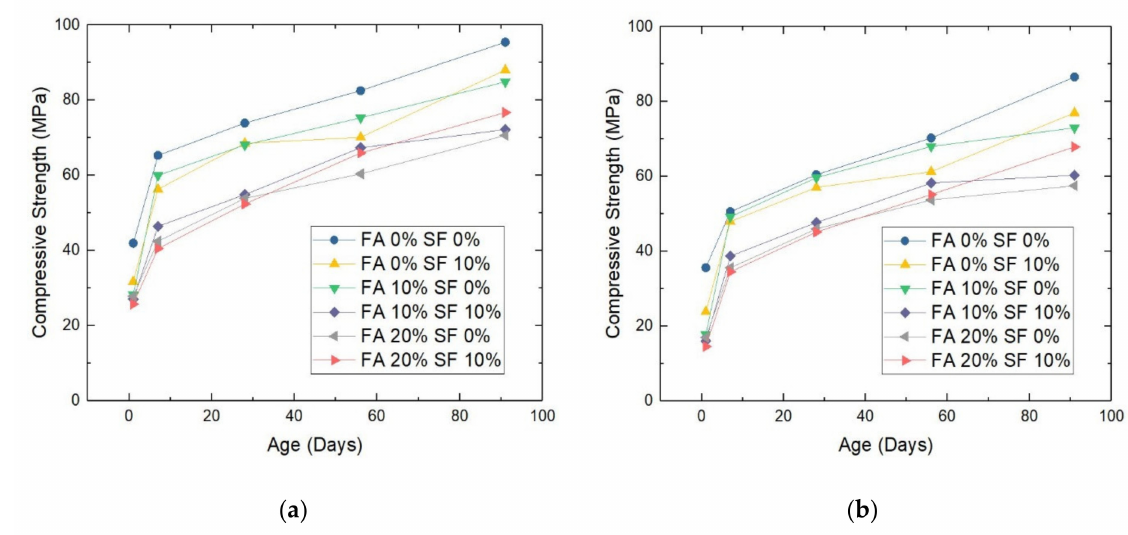
Figure 6. The compressive strength of HPC samples with a water/binder (W/B) ratio of ( a ) 0.28 or ( b ) 0.30. Note: FA = fly ash; SF = silica